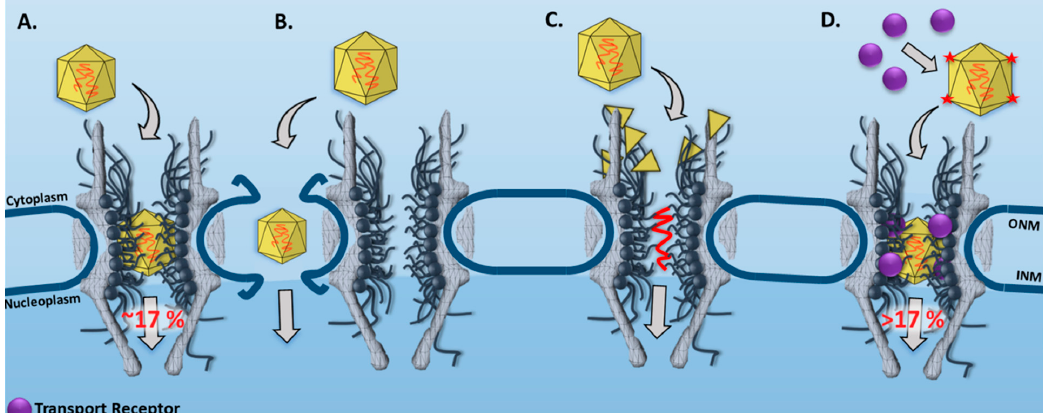
Figure 3. New features for the nuclear transport of AAV obtained by SPEED microscopy. ( A ) Our measurements revealed that approximately 17% of AAV2 capsids can be intact and successfully imported through the NPC to reach the nucleus. ( B ) A model in which AAV2 might bypass the NPC and gain access to the nucleus by disrupting the NE. ( C ) Another model in which the AAV2 capsid could disassemble on the cytoplasmic side of the NPC and inject viral genome into the nucleus through the NPC. ( D ) A suggested approach to increase the nuclear import success rate for AAV2 capsid as a nuclear gene delivery instrument. The transport receptors, the distance between NPCs, and the AAV2 particles are not to scale. ONM and INM indicate the outer nuclear membrane and inner nuclear membrane, respectively.